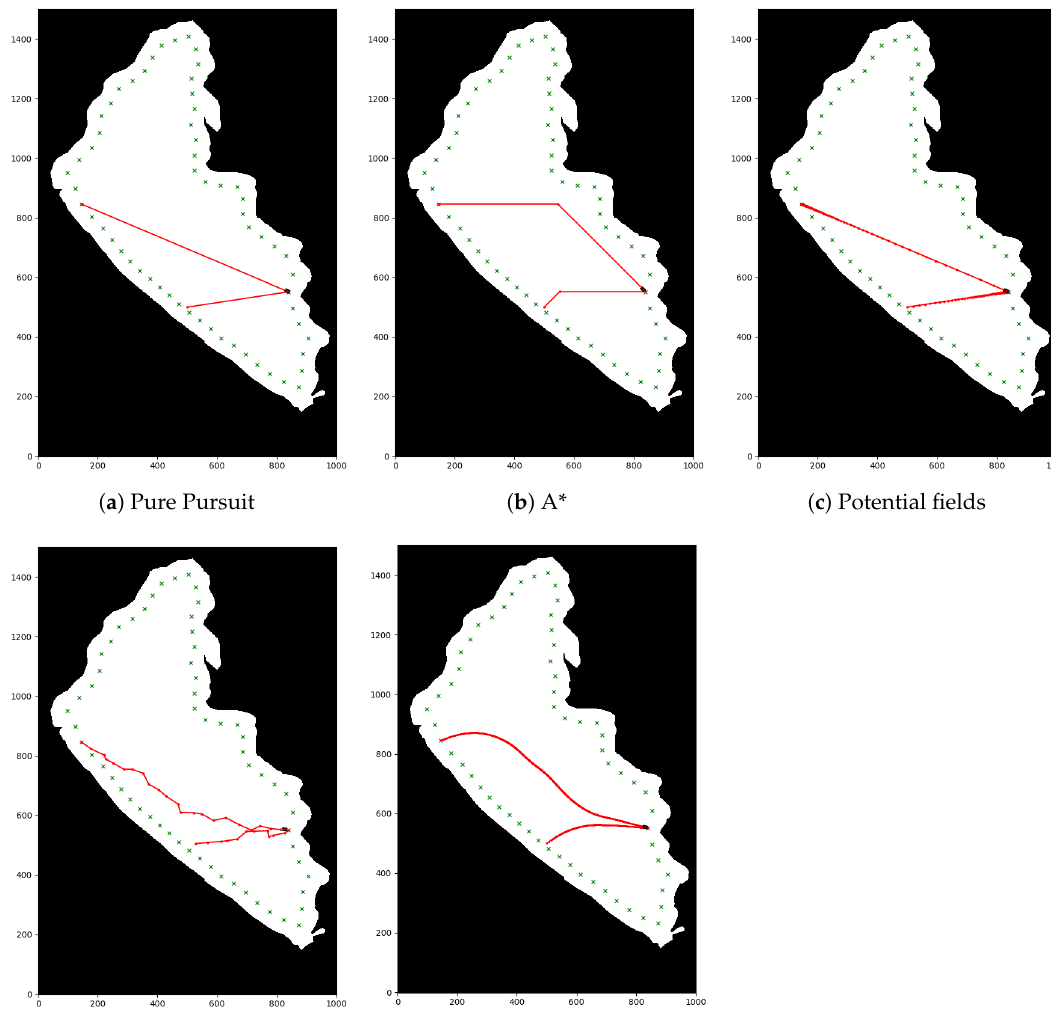
Figure 11. Visualization of generated paths for each of the studied